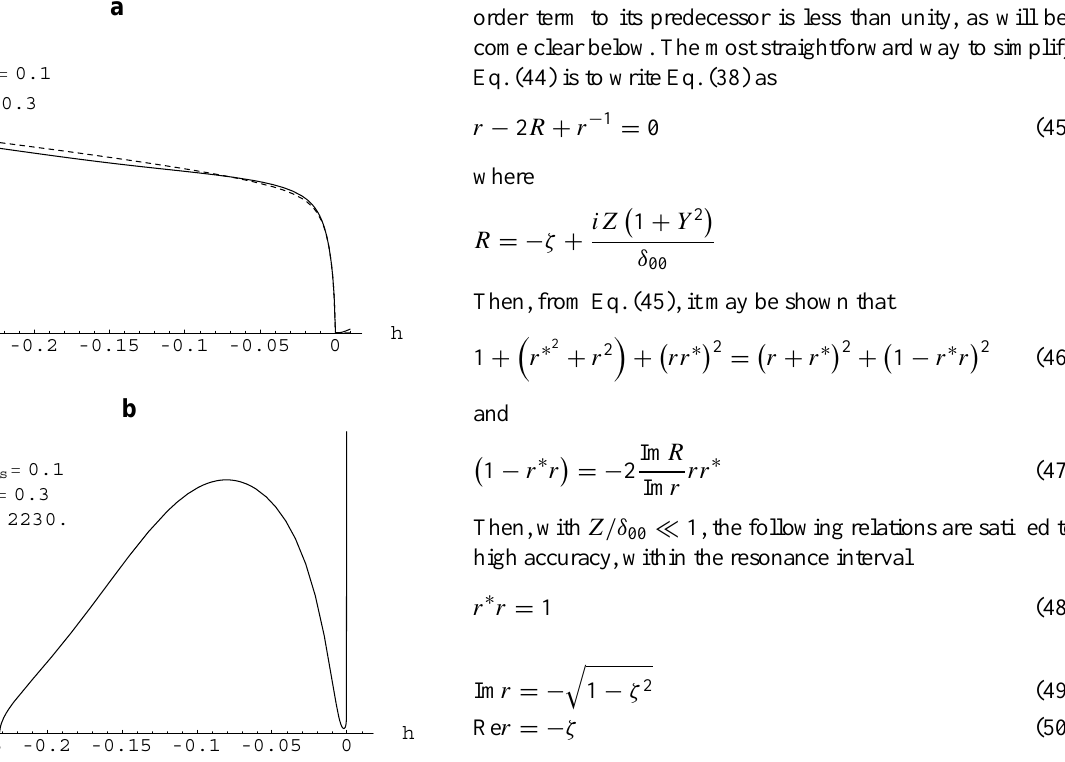
Fig. 6. Same as in Fig. 5, but with δ rms = 0 . 1. Fig.6